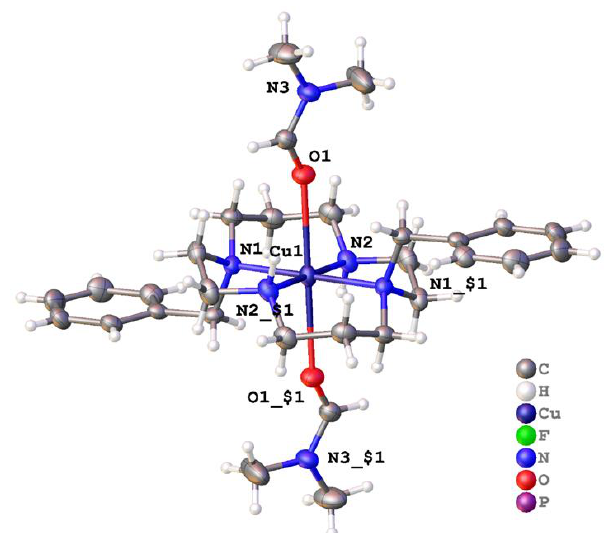
Figure 11. Coordination about the metal ion in [Cu( 2 )(OCHNMe 2 ) 2 ](PF 6 ) 2 · 2(OCHNMe 2 ) [57]. Atoms are drawn as 50% probability ellipsoids. For clarity, unbound solvent and anions are not shown. Symmetry operation for generating equivalent atoms: $1 = 1 − x , − y , − z .